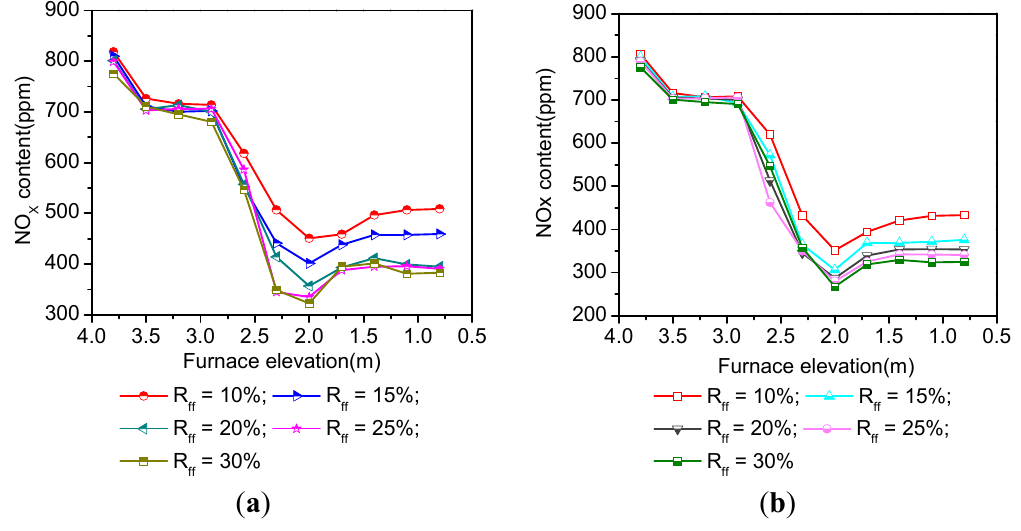
Figure 7. NO x distributions along with the height of the furnace under different R ff : ( a ) SAm reburning; and ( b ) cornstalk